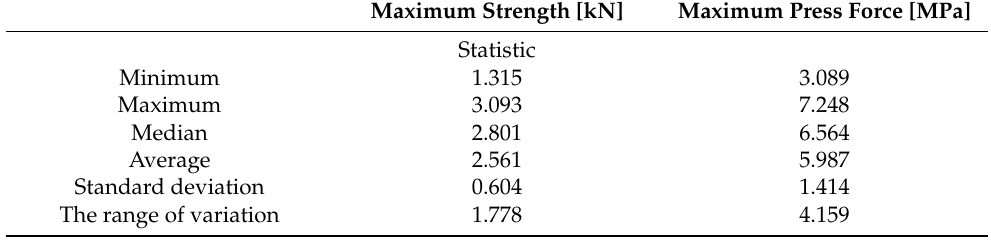
Table 19. Flexural strength tests for basalt dust B for all samples for water − mix ratio = 0.6 after 28 days.